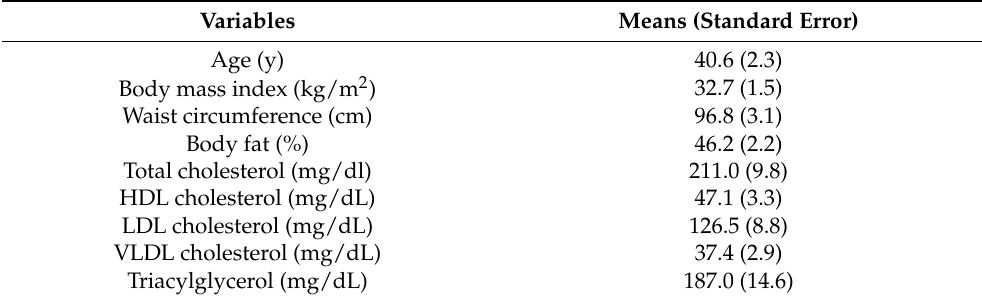
Figure 1. Flowchart of patients during intervention. Data adapted from Gomes et al. [19]. Table 3. Participants’ characteristics at the baseline (n =